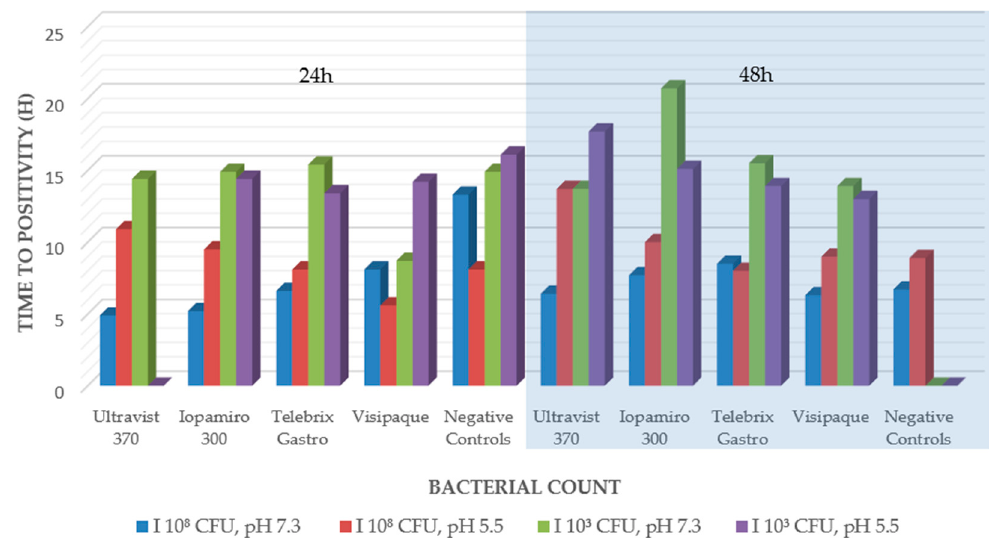
Figure 1. Antibacterial efficacy tests in liquid culture B. subtilis.